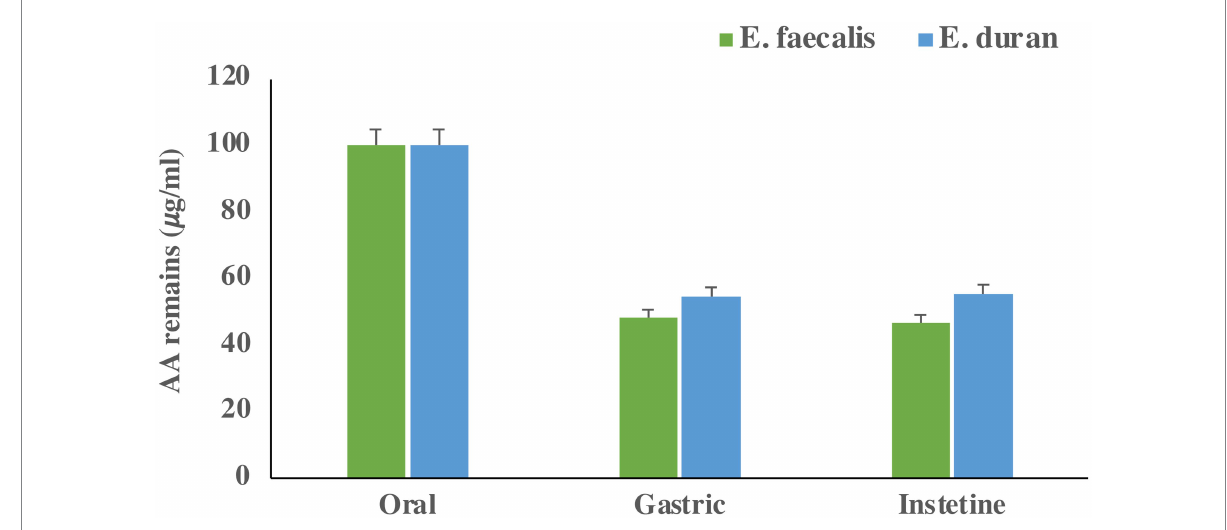
FIGURE 3 Acrylamide concentration ( 𝜇 g/mL) remain in GIT fluid after each step. Bars present means of triplicates and error bar present standard